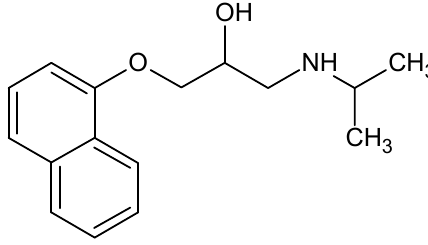
Figure 1. Chemical structure of propranolol.